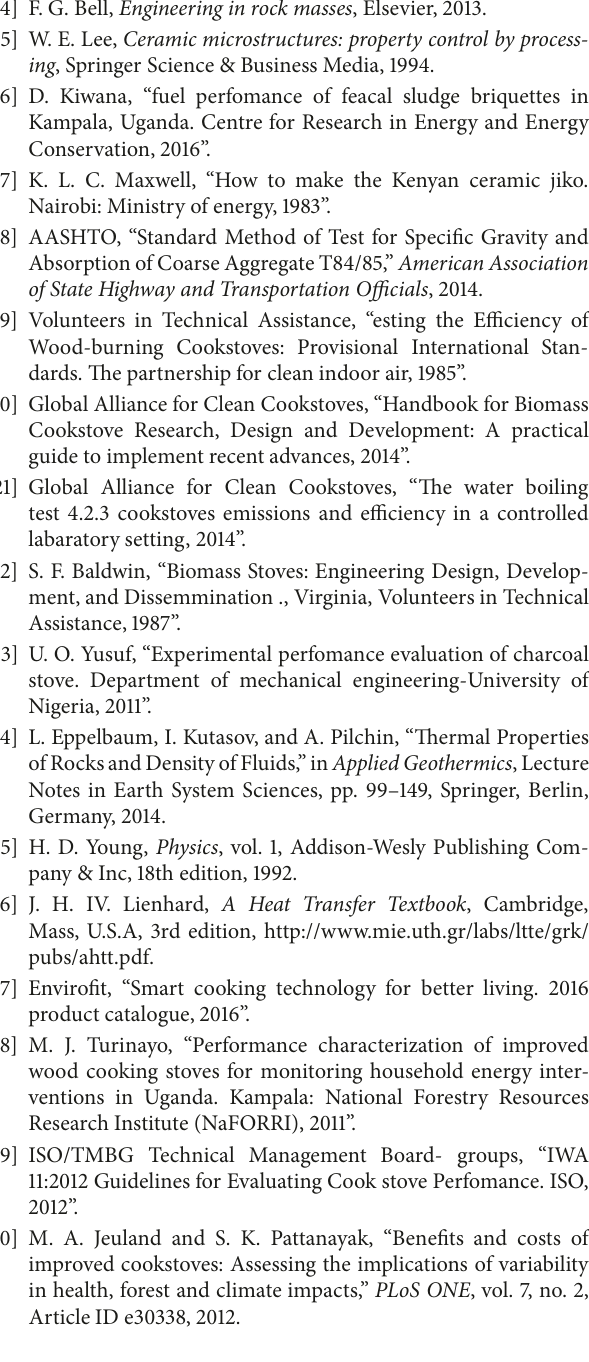
Figure S1: certificate of analysis for specific gravity and water absorption tests carried out. Figure S2: water absorp- tion results for granite rock aggregates. Figure S3: spe- cific gravity results for granite rock aggregates. Figure S4: thermal test results. Figure S5: water boiling test results. (Supplementary